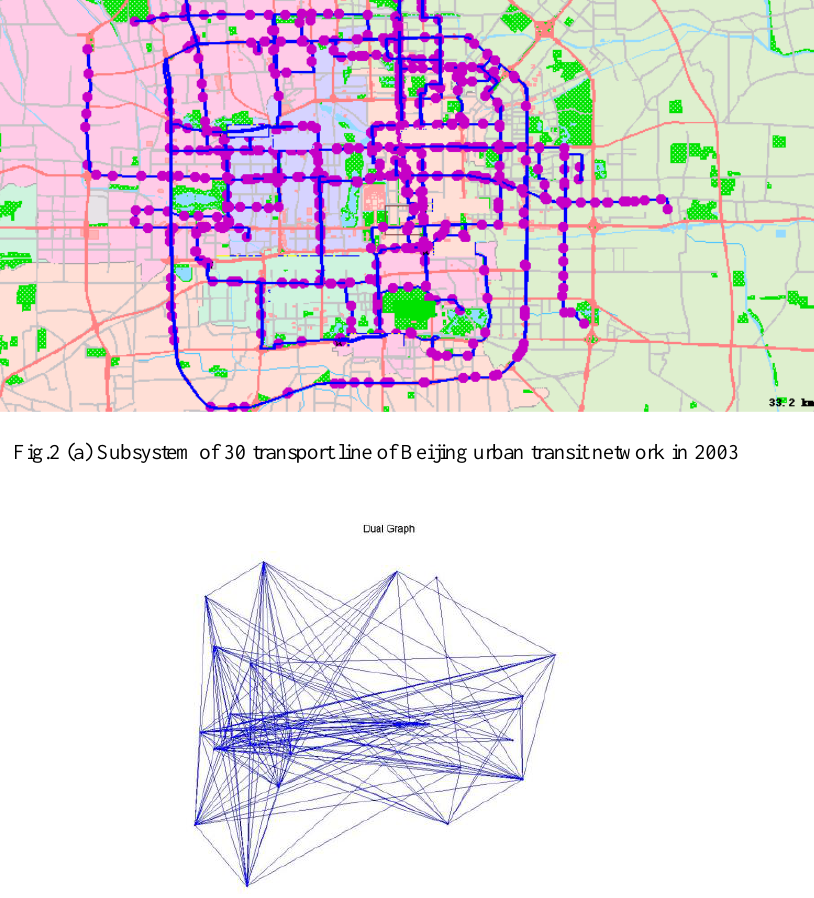
Fig2. (b) The corresponding dual connectivity graph